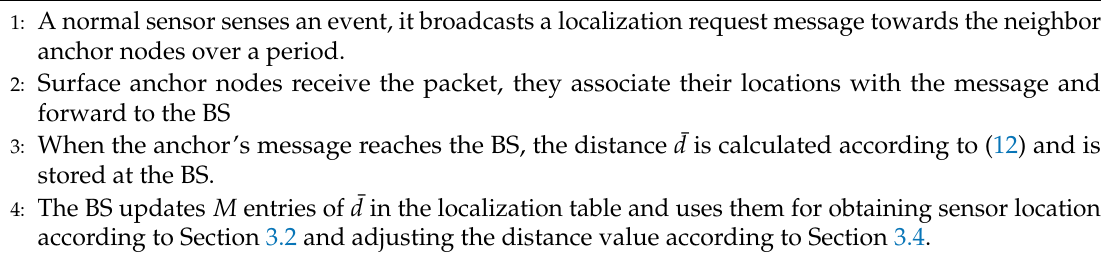
Algorithm 1 A framework of data transmission